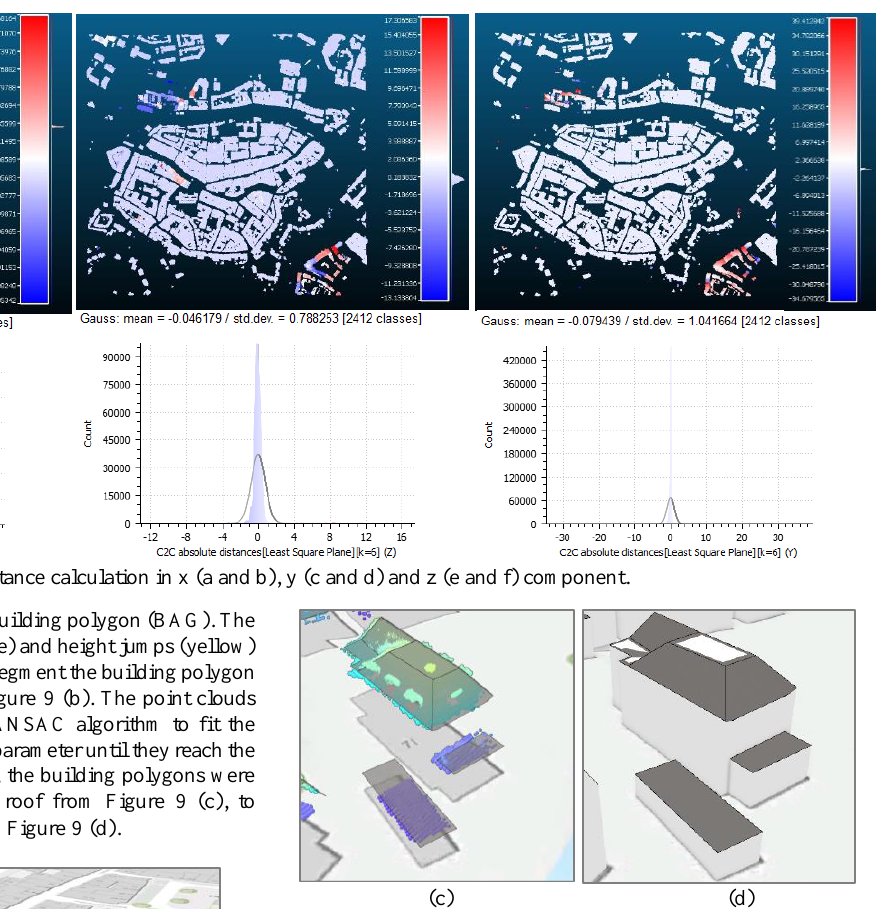
Figure 9. The sequence of 3D model generation.